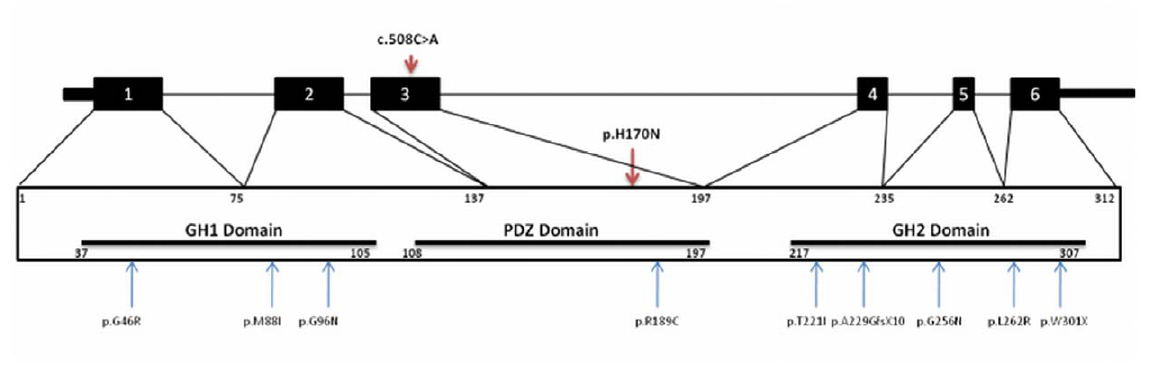
Figure 5. The two-dimensional structure of GIPC3 and the localization of identified mutations.